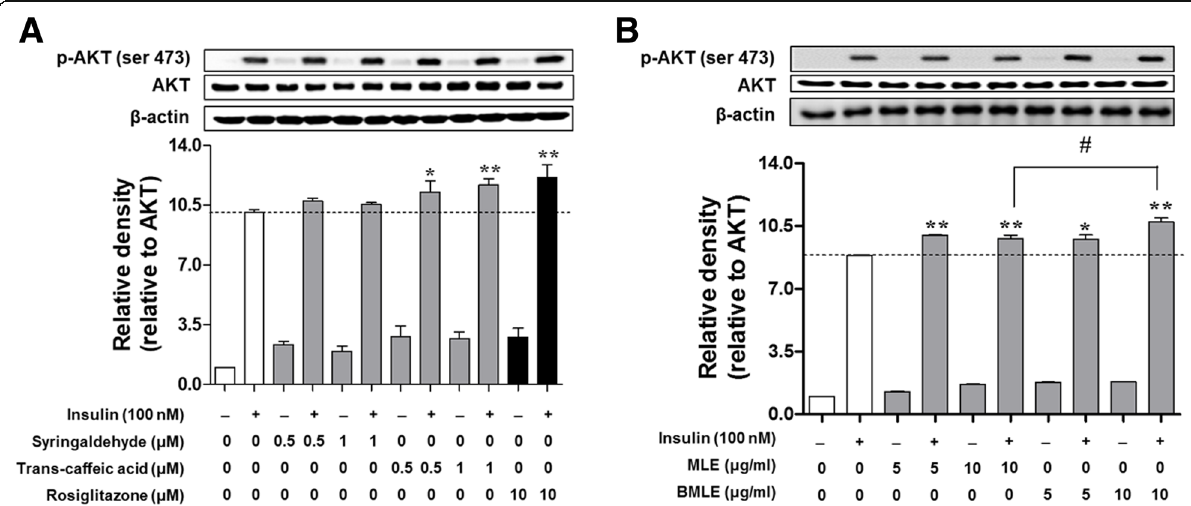
Fig. 3 Effect of two marker compounds ( a ) and unaltered mulberry leaf extract (MLE) and bioconverted mulberry leaf extract (BMLE) ( b ) on AKT phosphorylation in insulin-stimulated C2C12 myotubes. Cells were incubated in serum-starved DMEM for 1h and then treated with two marker compounds, MLE, BMLE, or rosiglitazone as a positive control for 1h. The medium was changed to Krebs-Ringer phosphate-HEPES buffer containing two marker compounds, MLE, BMLE or rosiglitazone for 30min. Thereafter, 100nM insulin was treated for 30min. Cells were lysed and proteins were employed by SDS-PAGE followed by Western blotting using primary antibodies targeting anti-phospho AKT, AKT and β -actin. The data depicted in bar graph expressed as the means ± SEM are an average of three similar and independent experiments and gel images are of representative blots. * P < 0.05 and ** P < 0.01 versus insulin-stimulated cells with no treatment; # P < 0.05 versus insulin-stimulated cells treated with